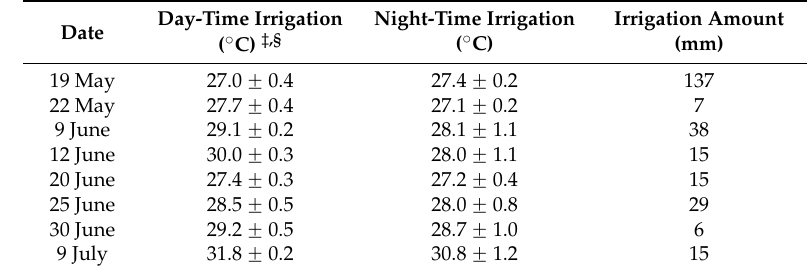
Table 1. Soil temperatures at 10 cm depth measured using a set of CS-655 soil sensors in a corn field with day-time vs. night-time irrigation at Uvalde, TX in 2014. Data are averages and standard deviations of soil temperatures from three sensors measured on 8 days at 10 p.m. following night-time irrigation (applied at 5 p.m. local time †